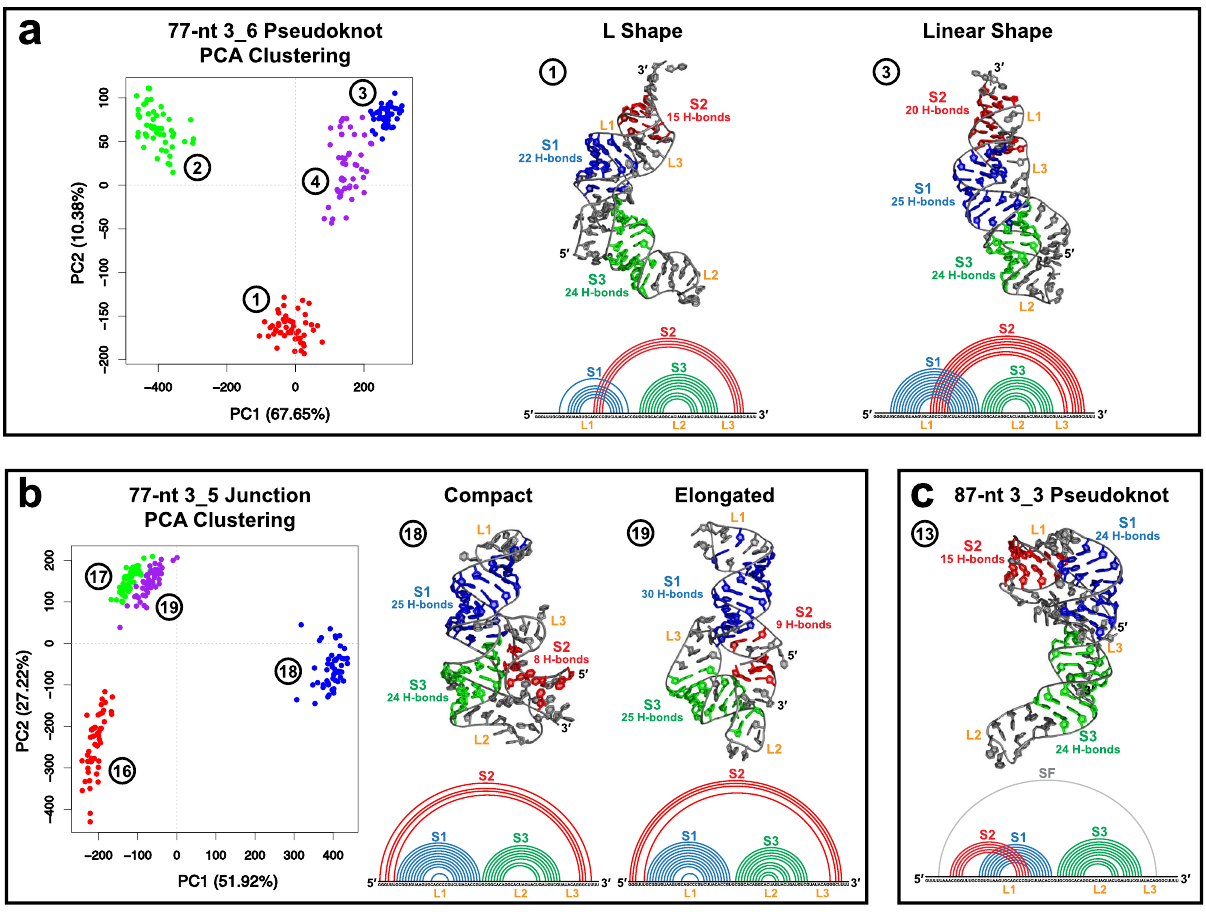
Fig. 2 Clustering analysis and representative structures for the three FSE motifs. Multi-trajectory clustering is performed to compare the 77-nt 3_6 trajectories (1 – 4 in Table 1) and select representative systems, as well as the 3_5 trajectories (16-19 in Table 1), with 50 equally spaced frames extracted from each trajectory. a For 3_6, two representative trajectories are chosen, sampling an L and a linear shape, respectively (shown as the largest cluster center structures found by additional single-trajectory clustering, see “ Methods ” ). b For 3_5, the two representative models capture compact and elongated shapes. c For 87-nt 3_3, only one system maintains the motif throughout the MD simulation. The 2D structures are extracted using 3DNA- DSSR 67 , and the numbers of hydrogen bonds formed in the stems (averaged over the last 500 ns of the simulations) are calculated using Gromacs 68